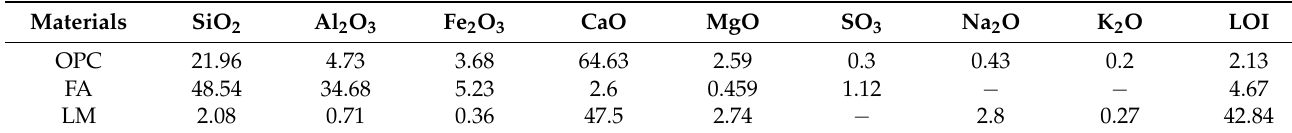
Table 1. Chemical compositions of the raw materials.